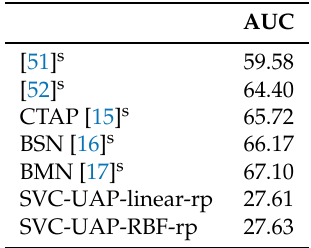
Table 4. Comparison with the state-of-the-art for the problem of AP in ActivityNet. s indicates the method is supervised.